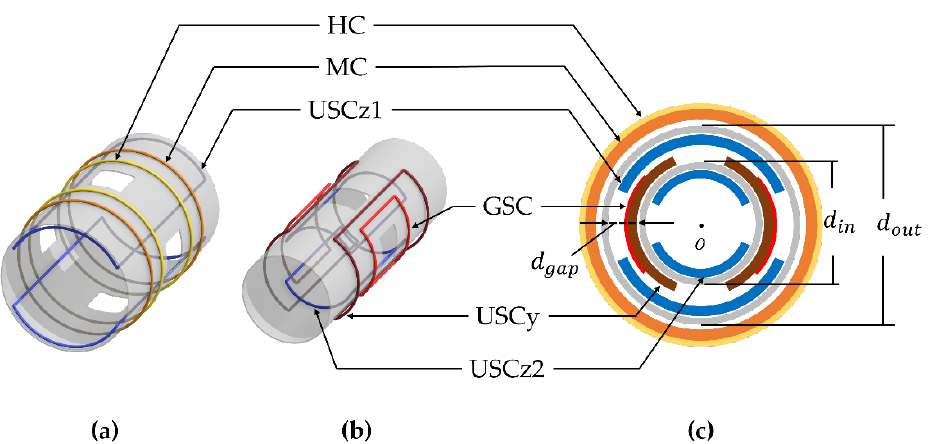
Figure 2. The proposed arrangement of the pipes (frame) and five pairs of coils: ( a ) HC and MC are installed outside the outer pipe, and USCz1 is installed inside the outer pipe; ( b ) USCy and GSC are installed outside the inner pipe, and USCz2 is installed inside the inner pipe; ( c ) the five pairs of coils integrated with the two pipes.